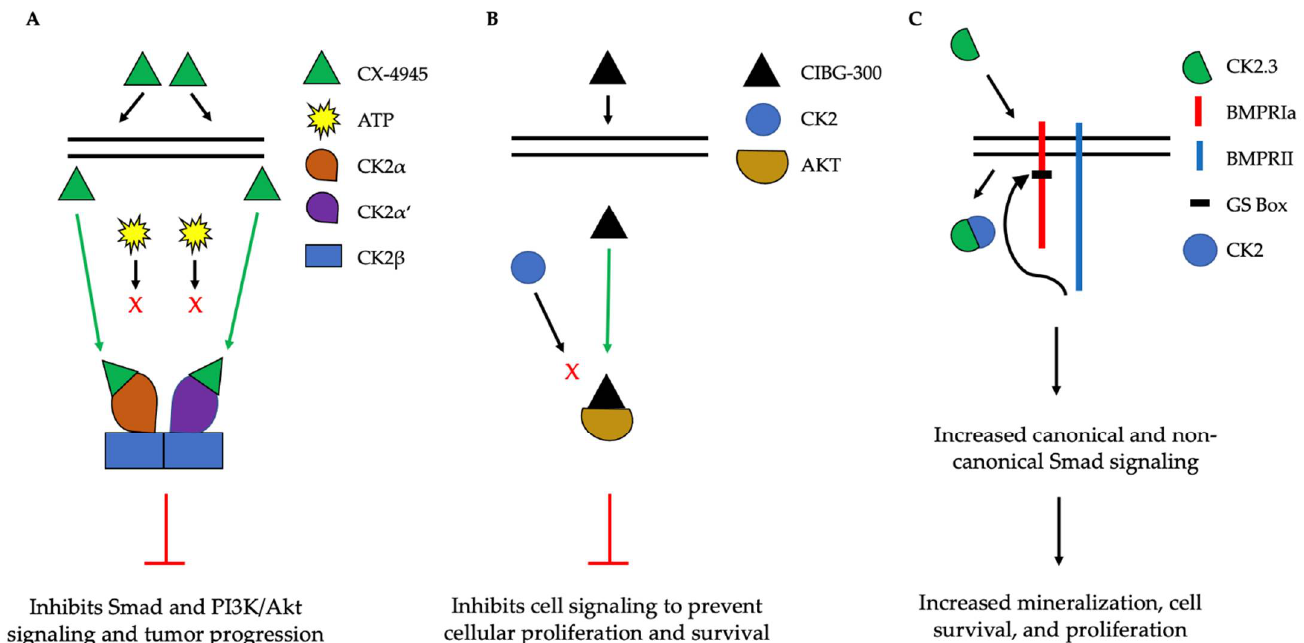
Figure 5. Simplified schematic demonstrating three therapeutics targeting the activity of CK2. ( A ). CX-4945 is a competitive ATP inhibitor that binds preferentially to ATP-pocket domains. Here, it binds to both CK2α and CK2α’, thereby preventing ATP from binding and activating CK2. CX-4945 has prevented tumor progression by inhibiting signaling pathways such as Smad and PI3K/AKT. ( B ). CIBG-300 functions by binding to conserved phosphorylation sequences on the substrates of CK2, such as Akt. This association prevents the phosphorylation of these substrates by CK2, leading to decreased cell signaling, proliferation, and survival. ( C ). CK2.3 is uptaken by cells and binds to CK2, therefore preventing its association with BMPRIa. As a result, BMPRII can phosphorylate BMPRIa, leading to the downstream activation of signaling pathways that induce mineralization and cell survival.